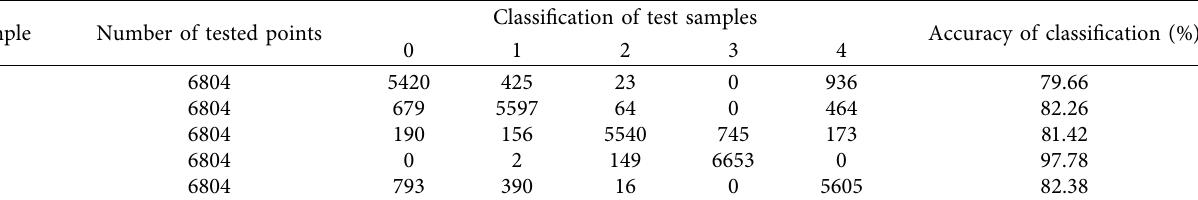
Table 2: Classification results of KNN model.